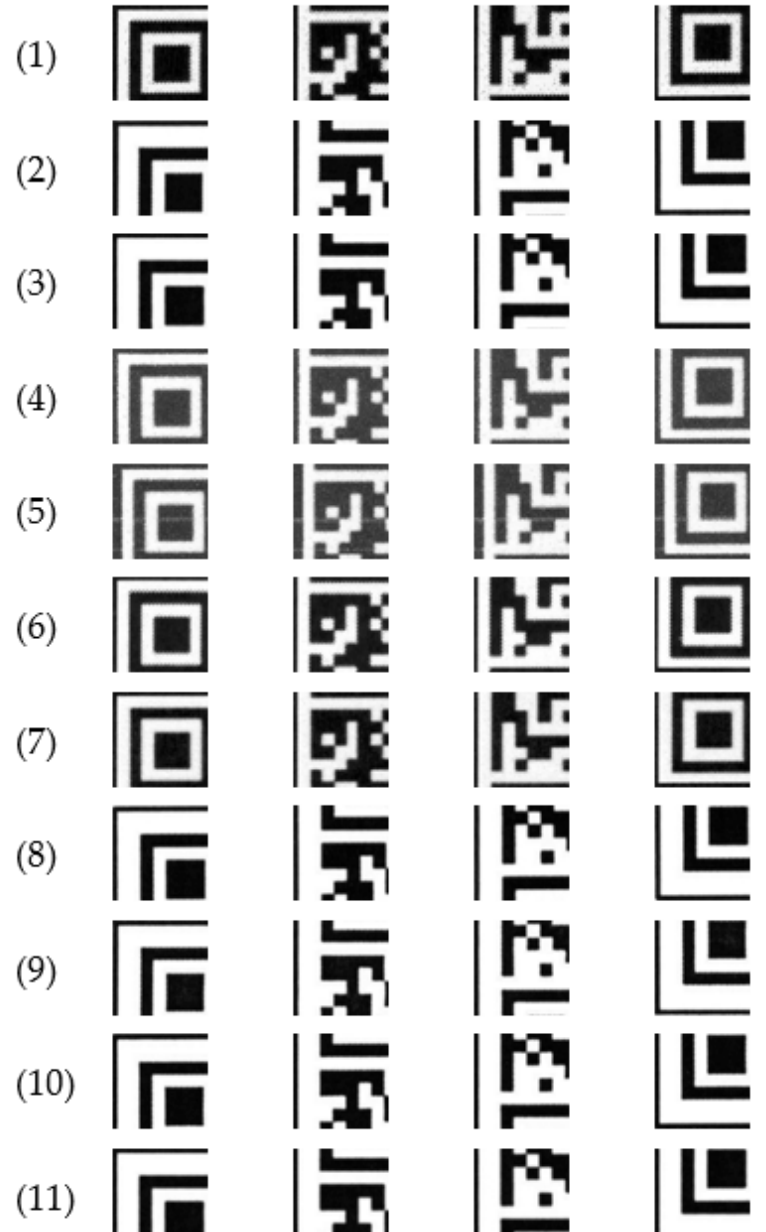
Figure 6. Image samples for BW QR codes printed by 11 printers (please note that each number refers an item in Table 1 for the printer and brand model).